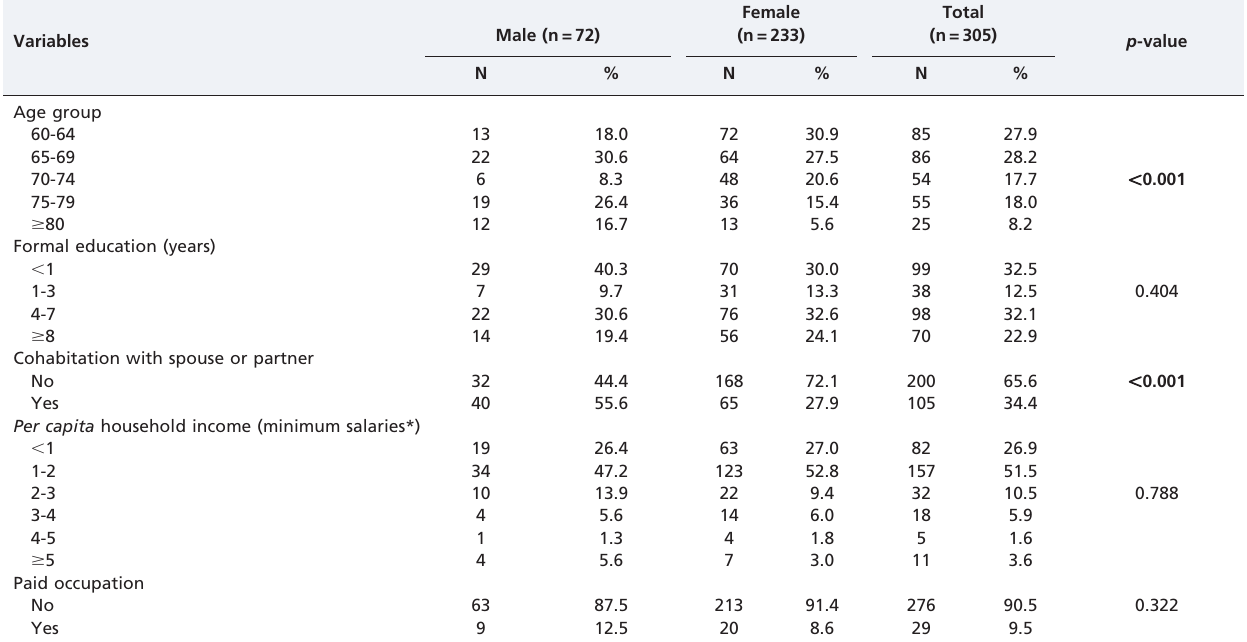
Table 1 - Sociodemographic variables investigated in elderly individuals attending senior community centers in Campo Grande, MS, Brazil,